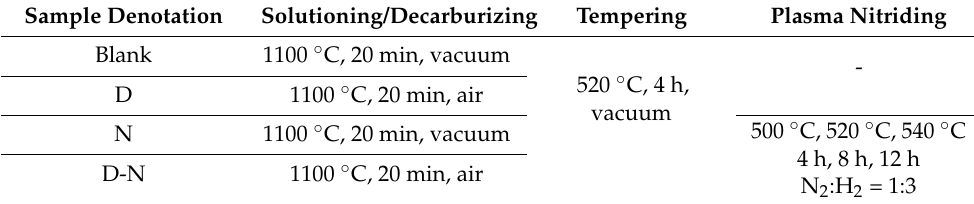
Table 2. Duplex process for